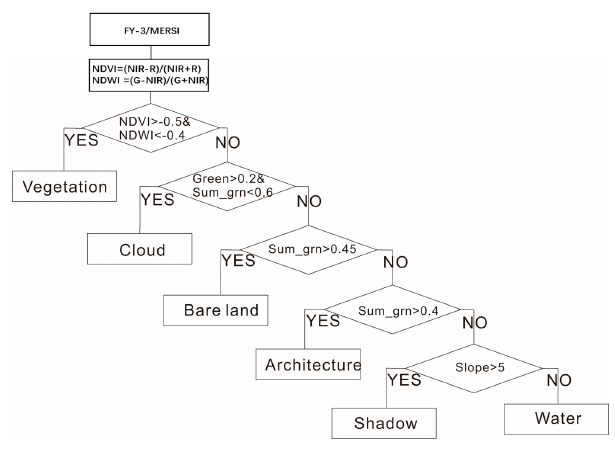
Figure 2. Knowledge decision tree classification diagram.